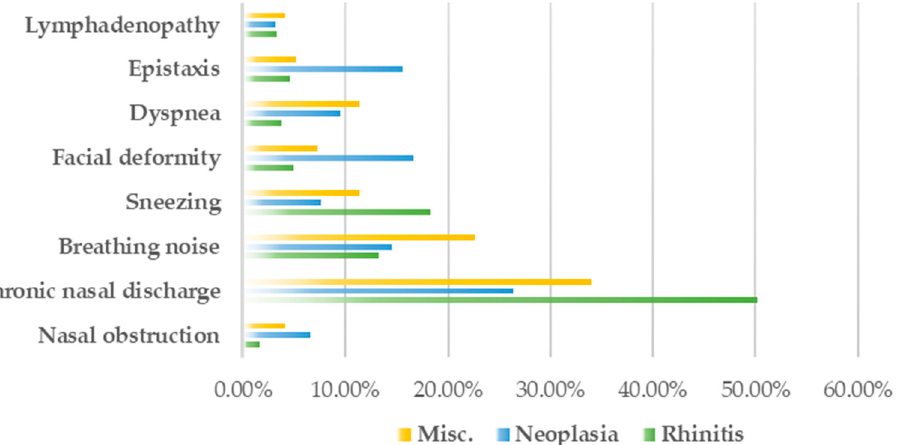
Figure 1. Clinical signs of each chronic URT disease in cats (Misc. includes anatomical defects, polyps, and foreign bodies). Table 1. Frequency of each predisposing factor across disease groups. Disease Group Total p -Value Factor Rhinitis Neoplasia